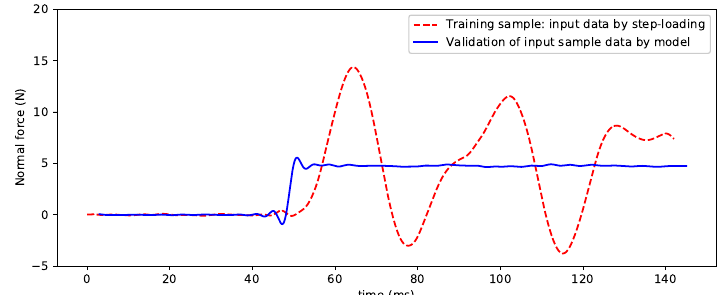
Figure 10. Input sample data and validation by CNN model (normal